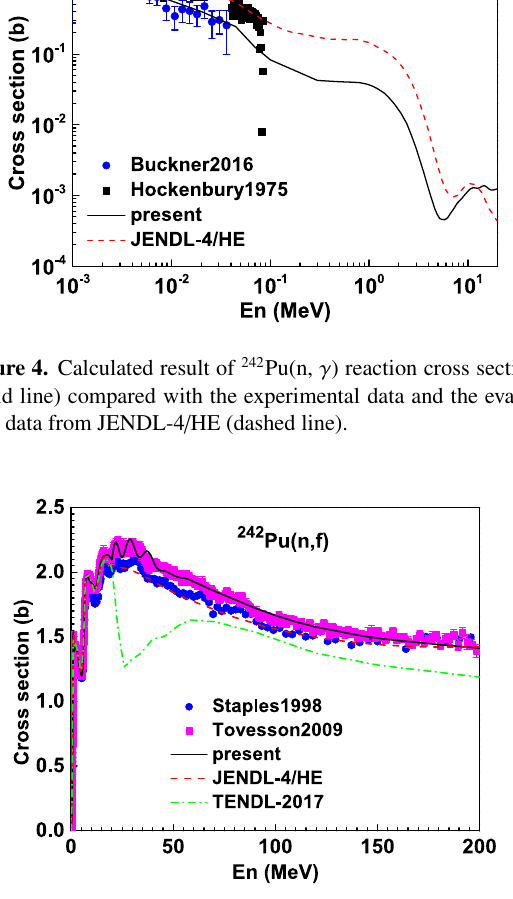
Figure 5. Calculated result of fission cross section (solid line) for n + 242 Pu reaction compared with the experimental data and the evaluated data from JENDL-4 / HE (dashed line) and TENDL (dash-dotted line).